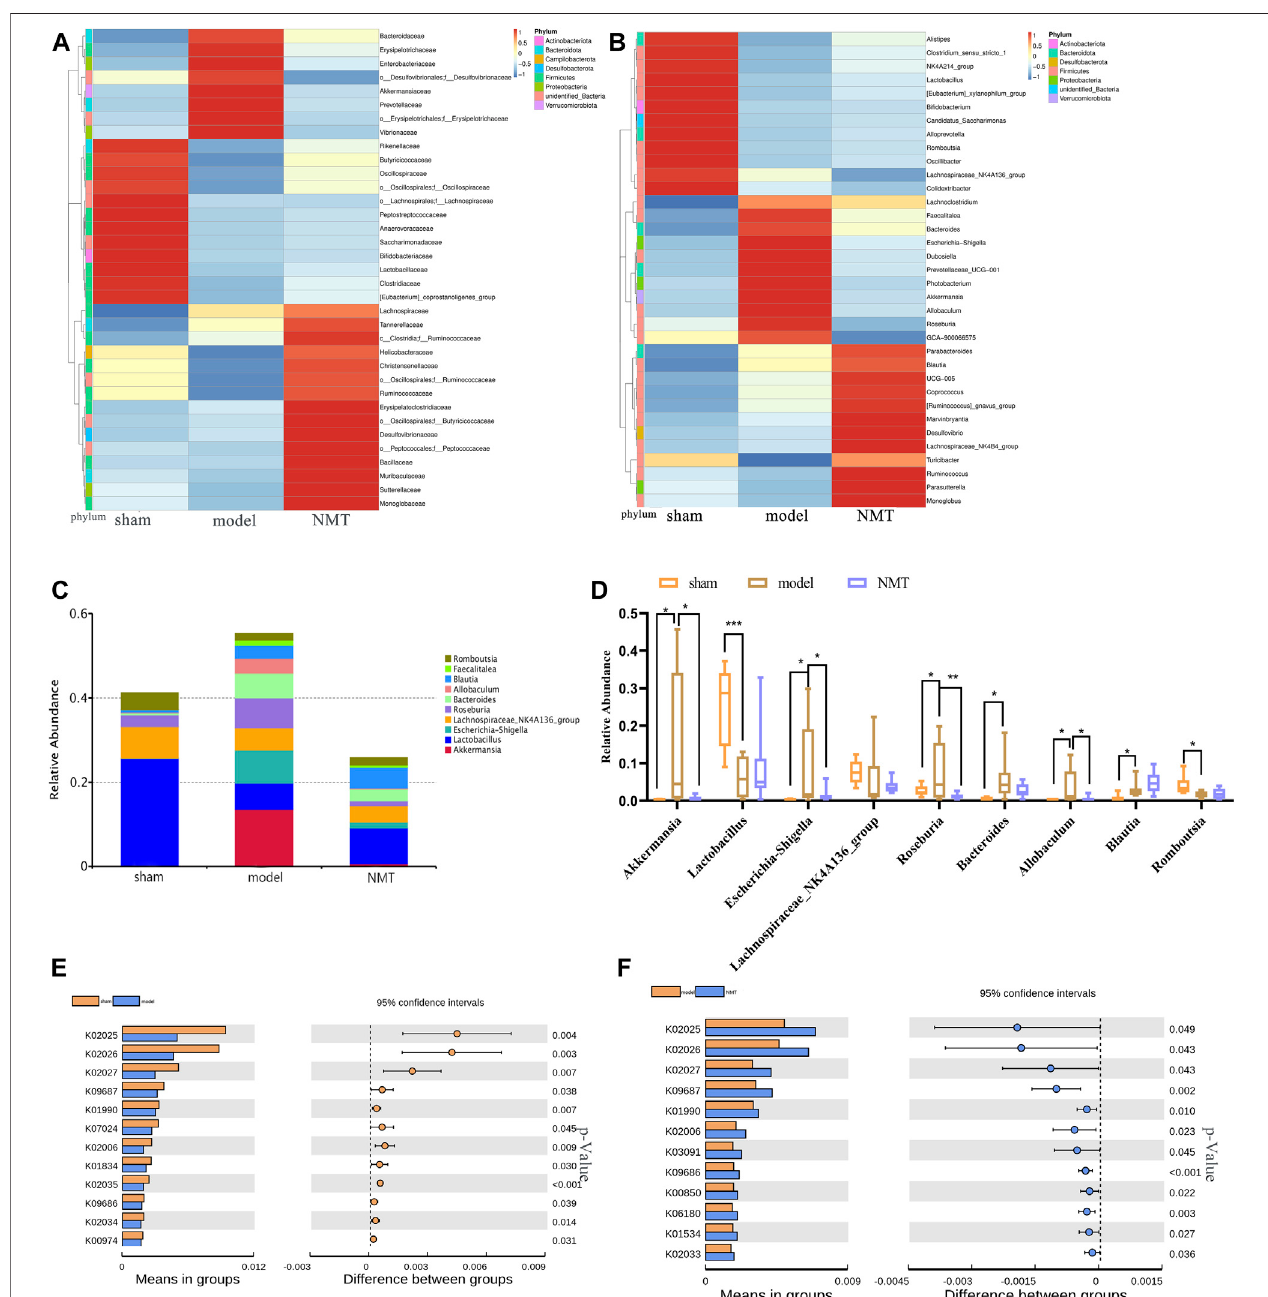
FIGURE 4 | Stroke recovery was related to the increase of bene fi cial bacteria in the intestinal fl ora. (A) Heatmap of the relative abundances of the 35 most abundant intestinal bacteria which signi fi cantly changed in stroke ( n (cid:1) 7) compared with those in sham ( n (cid:1) 8) and NMT ( n (cid:1) 9) group rats at the level of the family (FDR-adjusted p < 0.05, FDR < 5%). The color bar indicates Z score that represents the relative abundance. Z score < 0 and > 0 means the relative abundance is lower and higher than the mean. (B) Heatmap of the 35 most abundant bacterial genera, whose abundances changed signi fi cantly in different group rats. The color bar with numbers indicates the correlation coef fi cients. (C) The relative abundance of the gut bacterial phylum in each group (D) The relative abundances of the 9 most abundant bacterial genera that signi fi cantly correlated in different groups. Statistical signi fi cance was considered at * p < 0.05, ** p < 0.01 and *** p < 0.001 for all the tests. (E) Predicted metabolic pathways using PICRUSt analysis with Student ’ s t test ( p < 0.05).